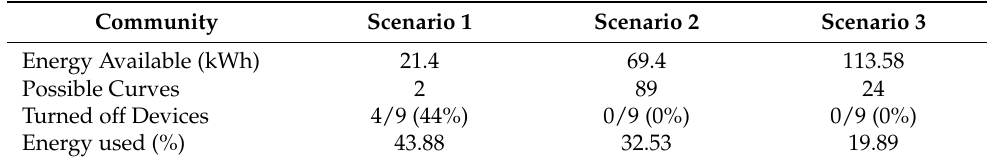
Table 7. Scenario brief